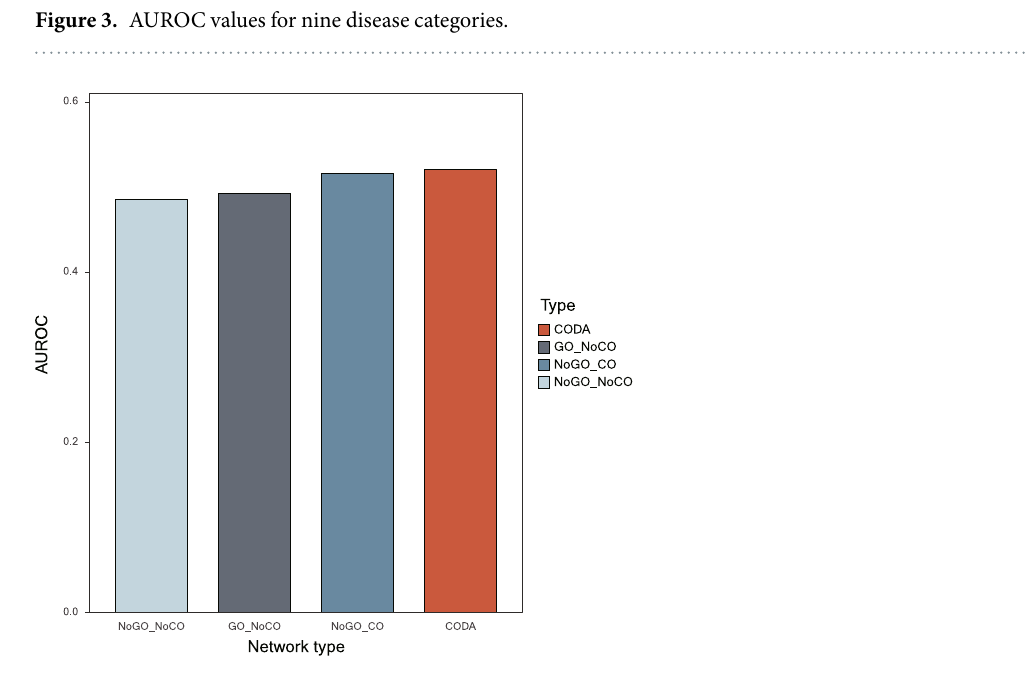
Figure 4. AUROC values of